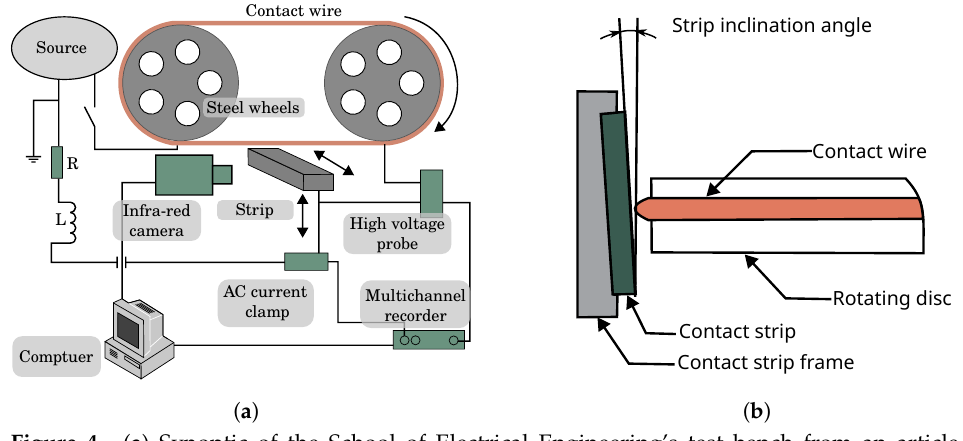
Figure 4. ( a ) Synoptic of the School of Electrical Engineering’s test bench from an article by Wu G. et al. [33]. Copyright (2023), with permission from Elsevier. ( b ) Test bench synoptic of the Tribology Research Institute, Southwest Jiatong University, from an article by Chen G. et al.